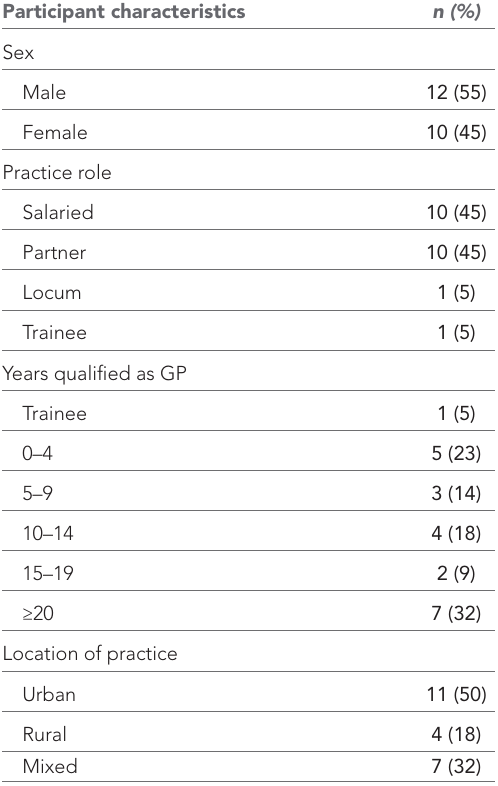
Table 1 Participant characteristics ( n = 22) Participant characteristics